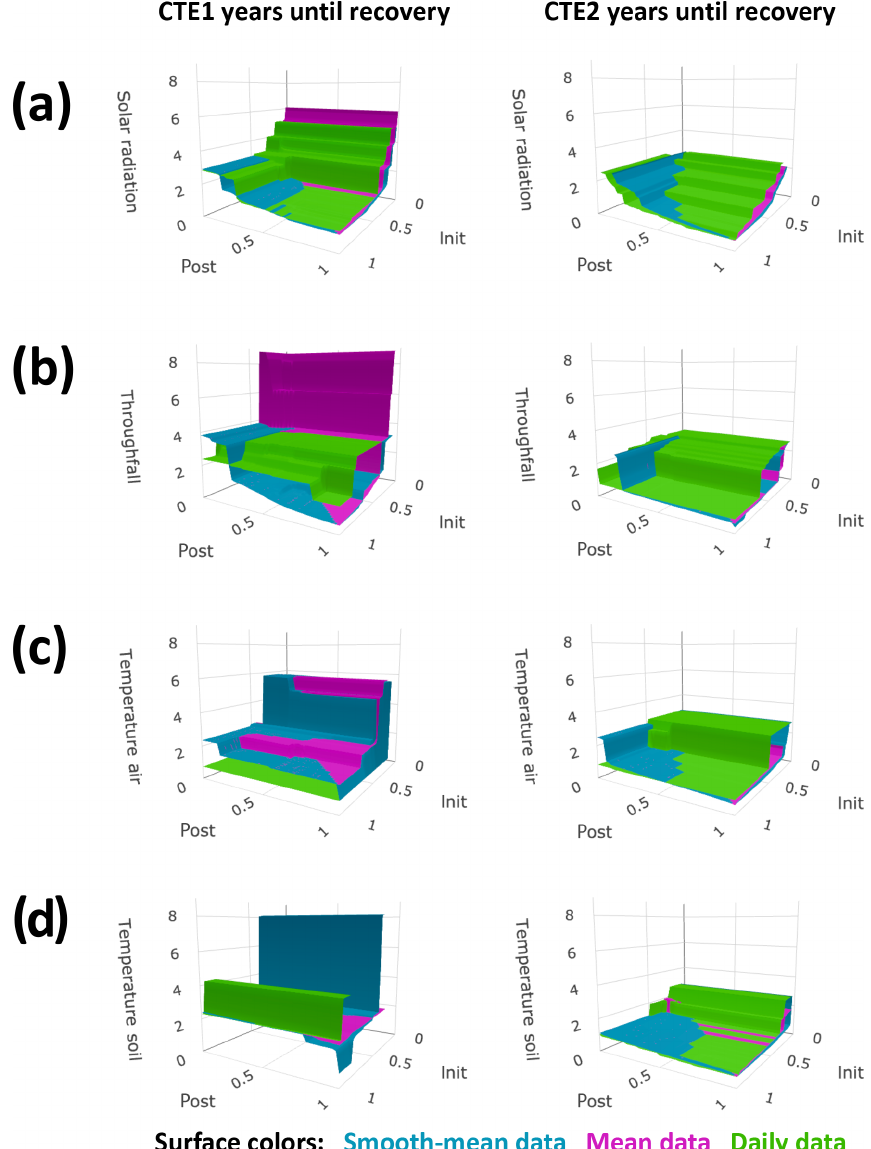
Figure 3. Sensitivity studies on primary factor calculated recovery times. Calculated years until recovery for each factor are plotted on the vertical axis, with variables of buffers on the other axes. The buffers are the required fraction of the acute change the difference in control and treated plots must approach, on the recovery day for initial closeness (init) and for 6 months after for postperiod small differences (post). Plot column one is for after canopy experiment (CTE) 1 and column 2 is for after CTE2. Surface color represents data summary methods as indicated, and absence of values for specified buffer conditions means the factor did not recover during the time period of the experiment with the specified buffers. Plots show (a) solar radiation beneath the canopy, (b) throughfall, (c) air temperature, and (d) soil